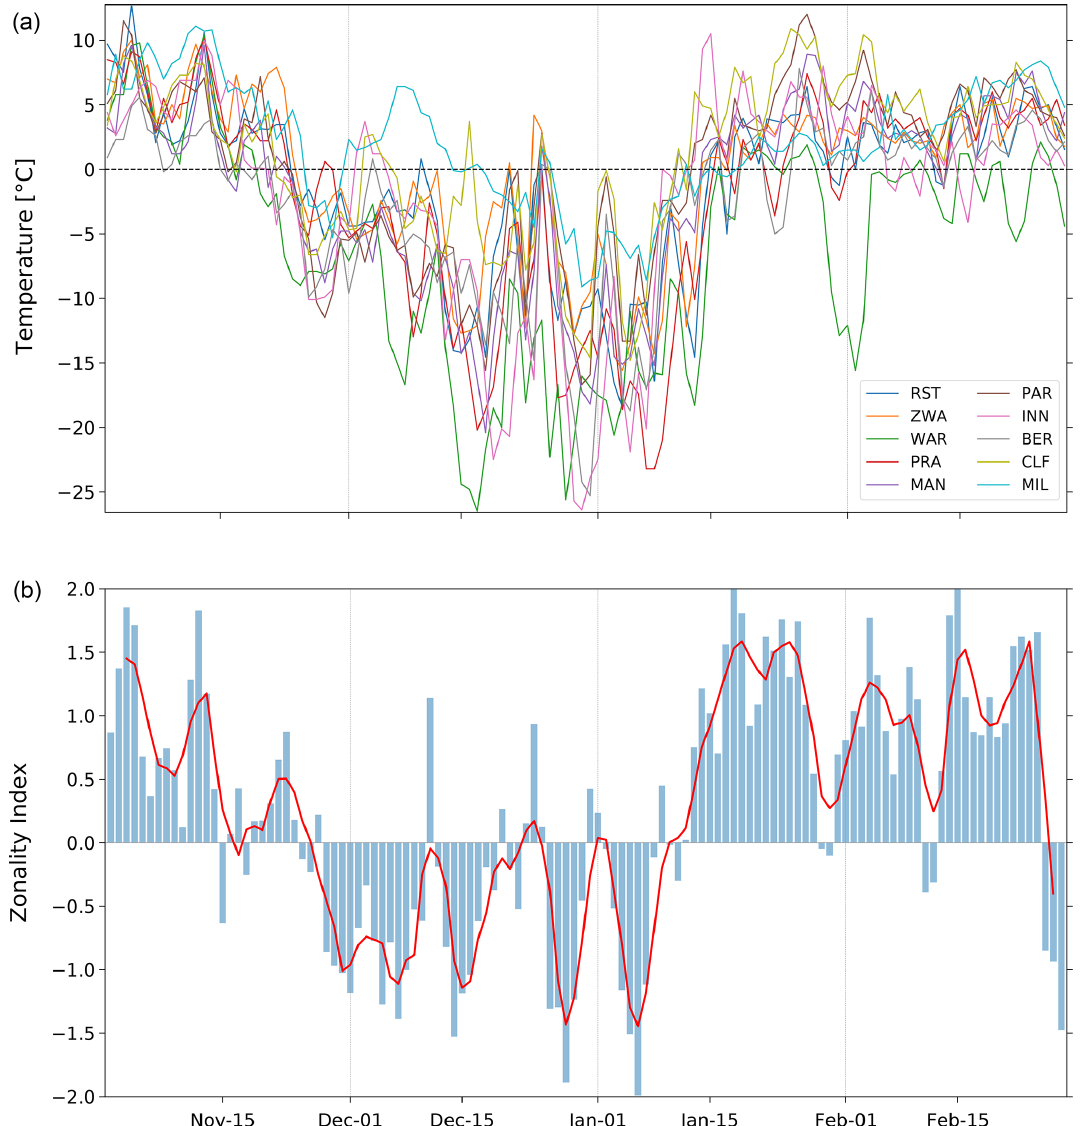
Figure 6. Daily mean air temperature from November to February 1788/89 at Rostock, Zwanenburg, Warsaw, Prague, Mannheim, Paris, Innsbruck, Bern, Clermont–Ferrand, and Milan (a) as well as a zonality index (b) , calculated as the standardised difference between the average SLP at Rome–Barcelona and Trondheim–Edinburgh; also shown is a 4d moving average